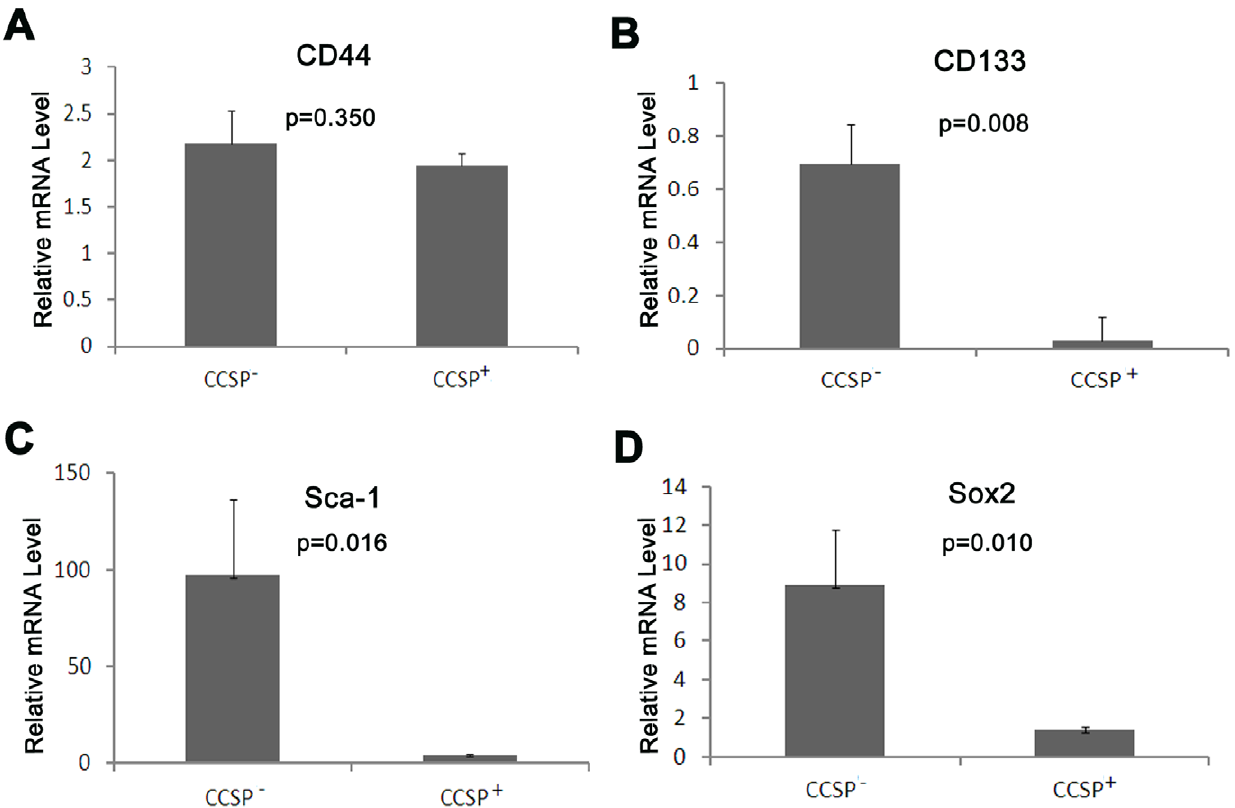
Figure 4. mRNA expression of stem cell markers in sorted cells. The mRNA of the stem cell markers CD44, CD133, Sca-1 and Sox2 was detected by qRT-PCR. A) The levels of CD44 mRNA were similar in CCSP + and CCSP 2 cells. B, C, D) Lower but still detectable CD133, Sca-1 and Sox2 mRNA levels in CCSP + cells.